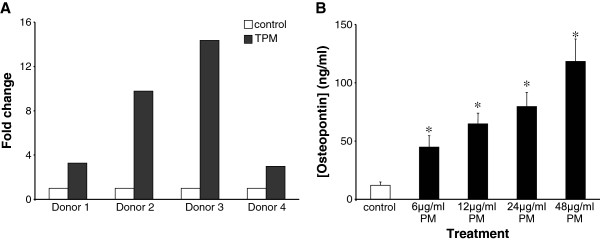
 Effects of PM treatment on osteopontin gene and protein expression. A, HUVECs from four different donors were exposed in triplicate experiments to 88 μg/ml PM for 24 h. Gene expression was examined using a PCR array. Data are mean fold changes in gene expression normalised to DMSO controls. B, 24-hour exposure to PM induced the secretion of osteopontin in a concentration dependent manner. Data are mean ± S.D. osteopontin concentrations (n = 6 in each case), as detected by electrochemiluminescence. *p < 0.05 compared to controls.